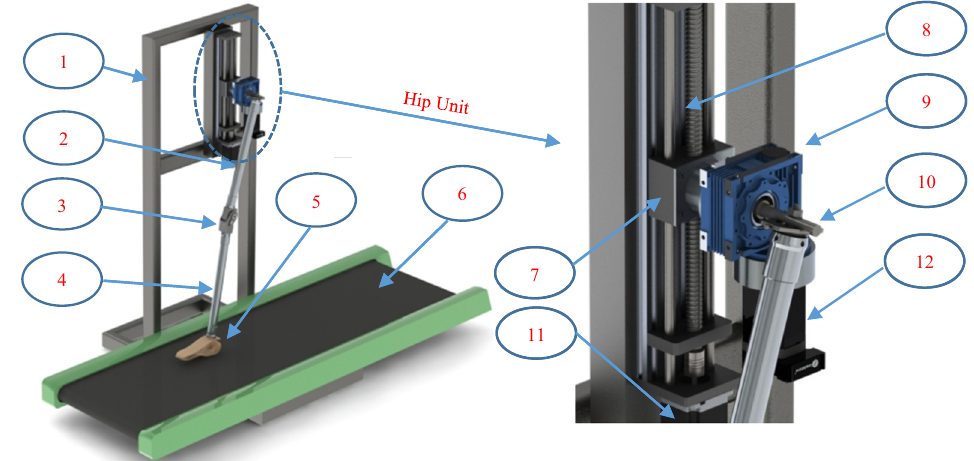
Figure 3: Final assembly of the test platform with transfemoral prosthesis.